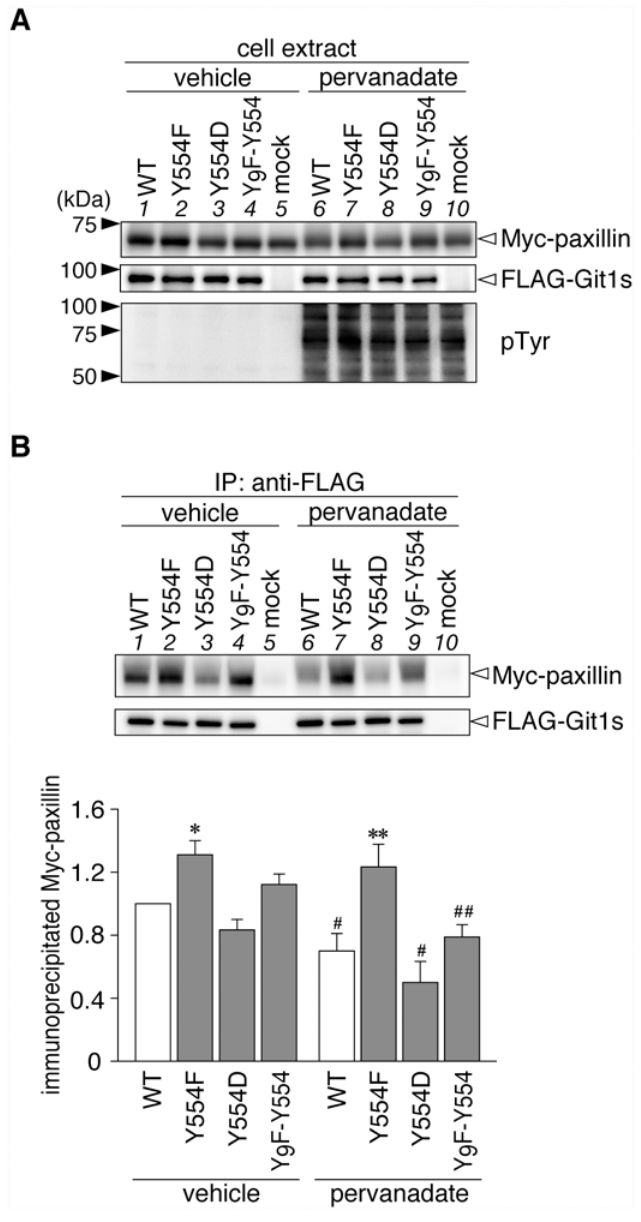
Fig 3. Git1 phosphorylation at Tyr-554 weakened its association with paxillin. A , Western blotting of protein expression levels, and tyrosine phosphorylation of all proteins in HEK293T cells expressing FLAG- tagged Git1 proteins together with Myc-tagged paxillin. Western blotting analyses were performed using anti- FLAG M2, anti-Myc 9E10, or anti-phosphotyrosine PY20. B , Co-immunoprecipitaion of Git1 mutants with paxillin. The amount of FLAG-Git1 and Myc-paxillin in the anti-FLAG immunoprecipitates was determined as above. Data are the mean ± S.E. (error bars; n = 3). * , P < 0.05 or ** , P < 0.01 significantly different from the wild-type with the same treatment; # , P < 0.05 or ## , P < 0.01 significant difference between vehicle- and pervanadate-treated groups by ANOVA with Fisher ’ s PLSD post hoc